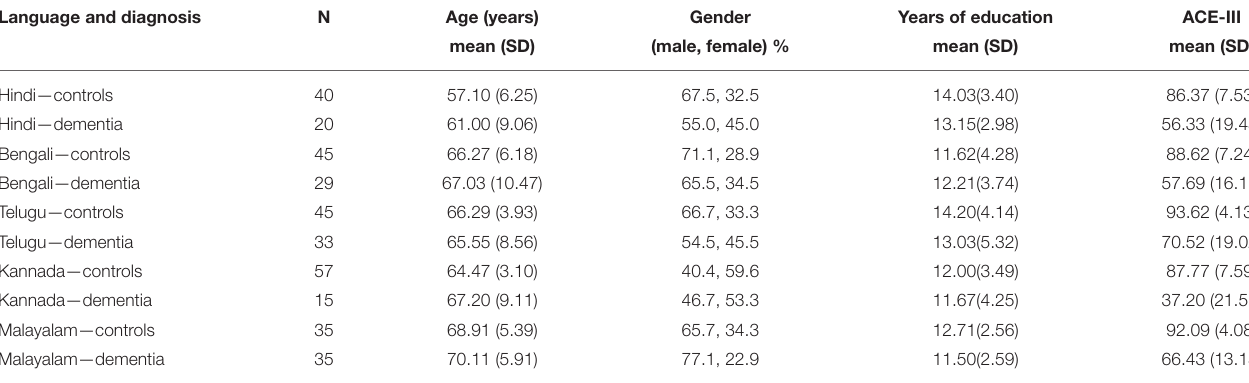
TABLE 1 | Demographic profile of Hindi, Bengali, Telugu, Kannada, and Malayalam speaking healthy controls and dementia. Language and diagnosis N Age (years)